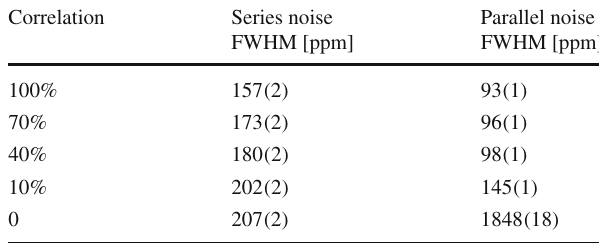
Table 2 Results of the application of the DPLMS method extension with correlated